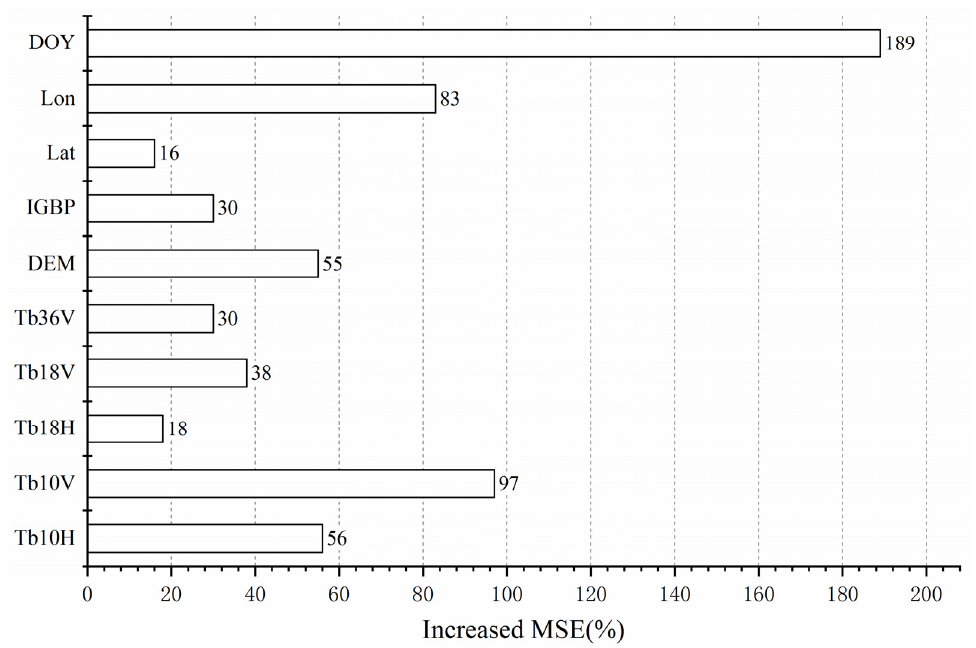
Figure 3. Relative variable importance of random forest based on increased mean square error (MSE). Tb36V is V polarization brightness temperature of 36.5 GHz, Tb18V is V polarization brightness temperature of 18.7 GHz, Tb18H is H polarization brightness temperature of 18.7 GHz, Tb10V is V polarization brightness temperature of 10.7 GHz, Tb10H is H polarization brightness temperature of 10.7 GHz.